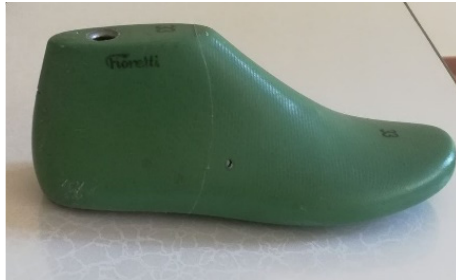
Figure 11. The last.